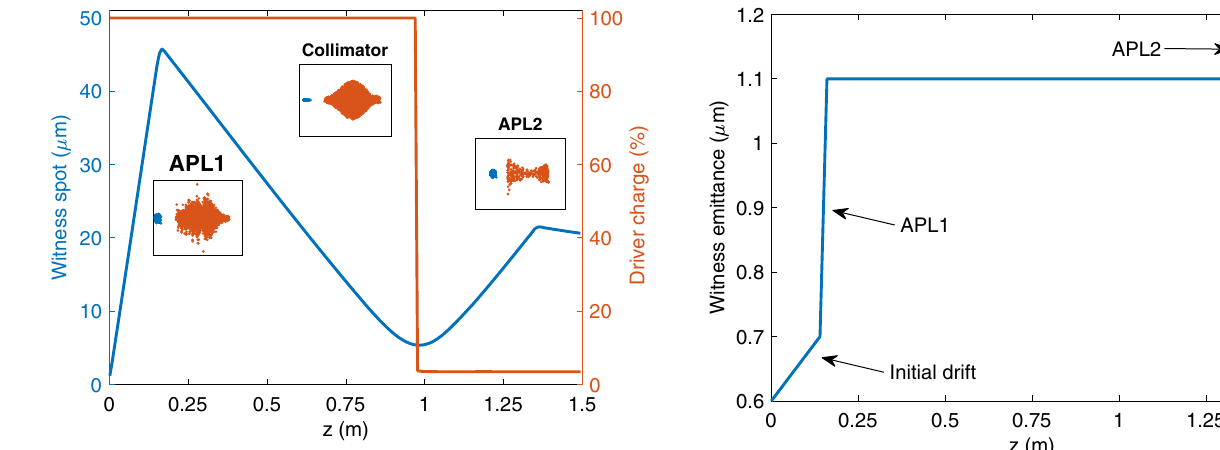
FIG. 6. Evolution of the witness normalized emittance along the beam line. The points where there is an increase of such a quantity are labeled